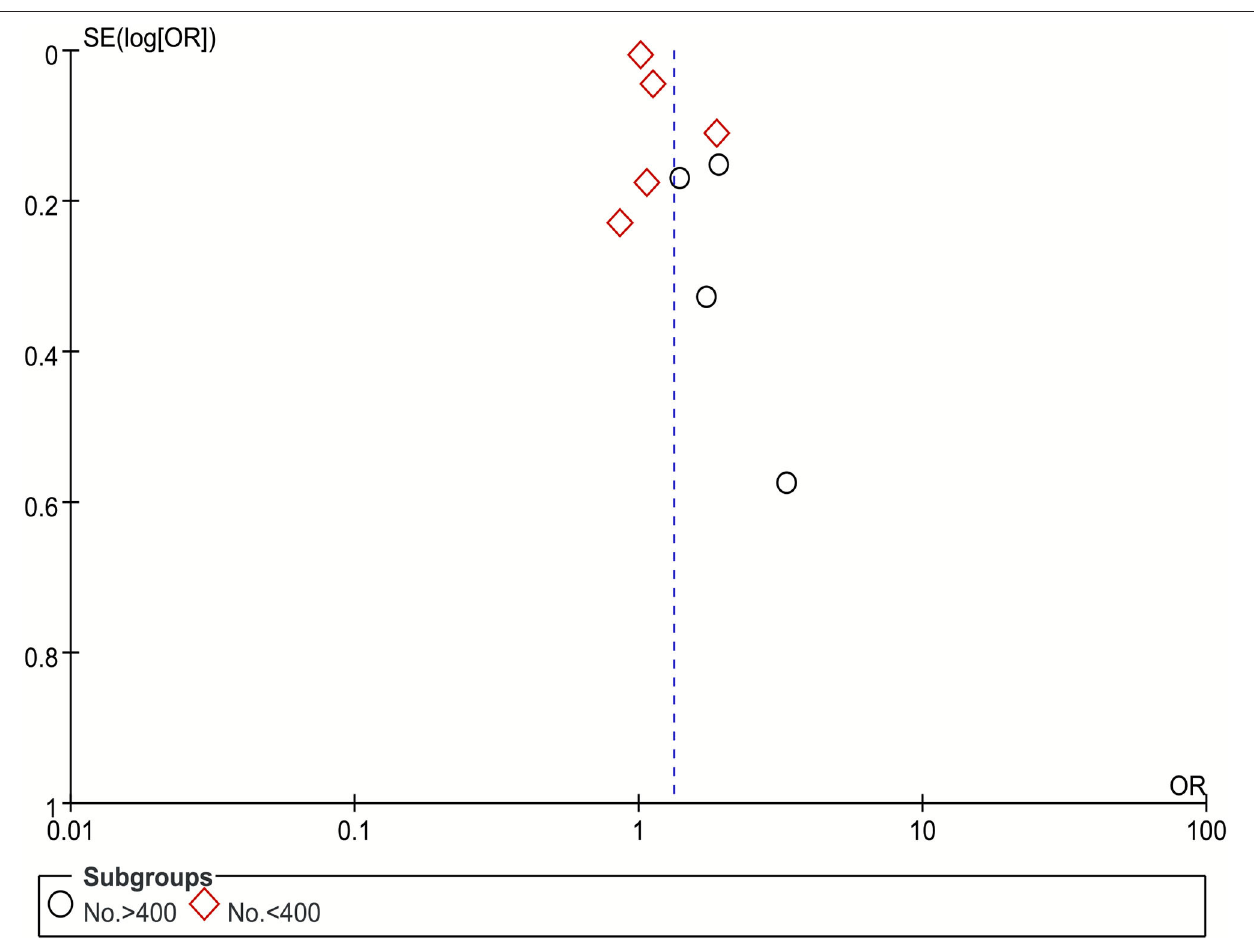
FIGURE 4 | Funnel plot of publication bias of NLR with poor